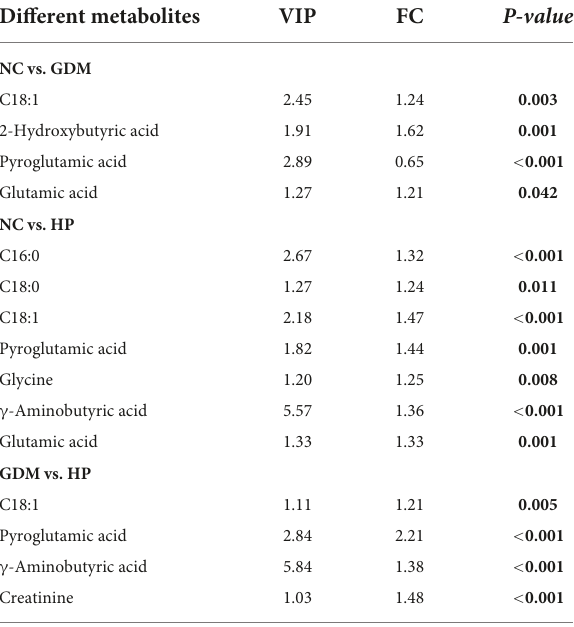
TABLE 2 Potential biomarkers discovered by VIP, FC, and adjusted p -values.